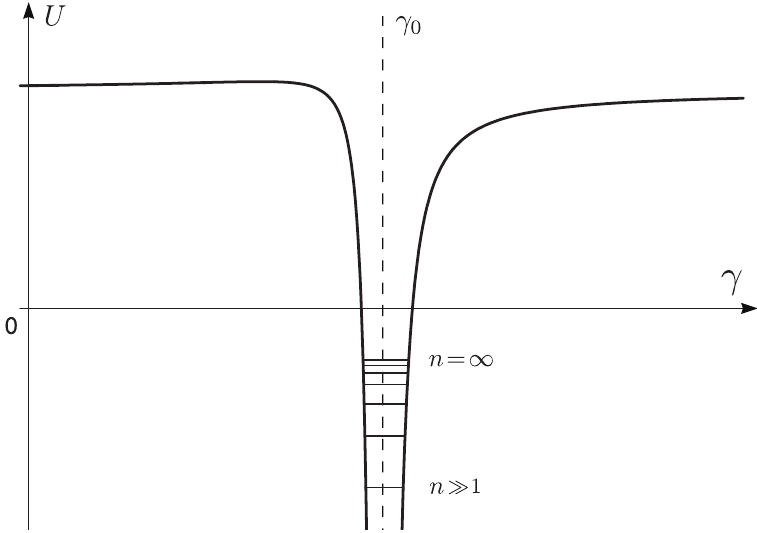
Figure 1. The potential energy for quantum gravitational